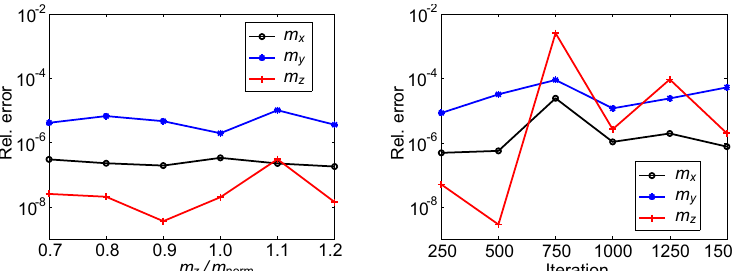
Figure 5. The relative errors for gradients determined by difference quotients and the adjoint method for the dipole components. Thereby, on the left side, different points in parameter space are considered. On the right side, the dependence of the error on a different number of time iteration steps is shown.